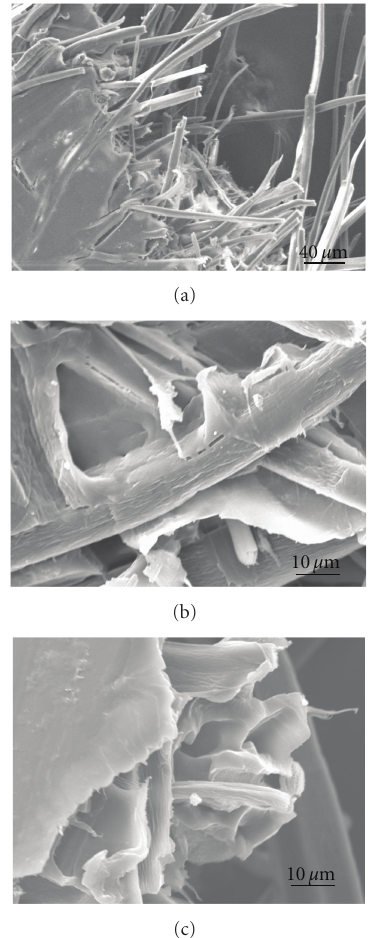
Figure 6: SEM images of the fracture surfaces of kenaf fiber/PP composites. (a) PP composites reinforced with untreated fibers; (b) PP composites reinforced with INI-treated fibers (INI treatment conditions were 100 ◦ C, Na 2 CO 3 :CaCl 2 = 1:2, mol: mol), and (c) PP composites reinforced with INI-treated fibers (INI treatment conditions were 160 ◦ C, Na 2 CO 3 : CaCl 2 = 1 :1, mol